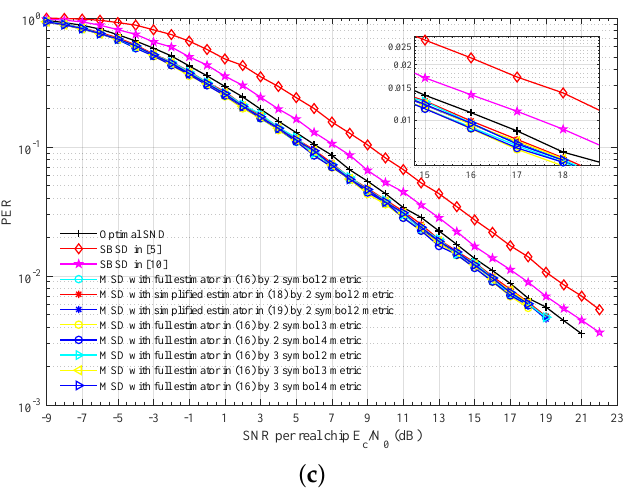
Figure 7. Detection performance comparisons of various detection schemes over a slow Rayleigh fading channel. ( a ) BER performance; ( b ) SER performance; ( c ) PER performance.